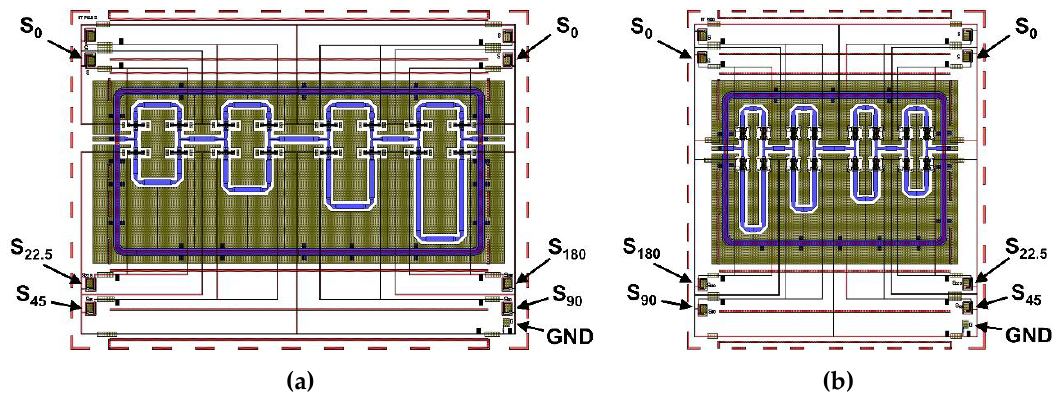
Figure 9. Top-view layout topology of the ( a ) K band (19.5 GHz center frequency) and of the ( b ) Ka band (29.3 GHz center frequency) RF-MEMS phase shifters design concepts.